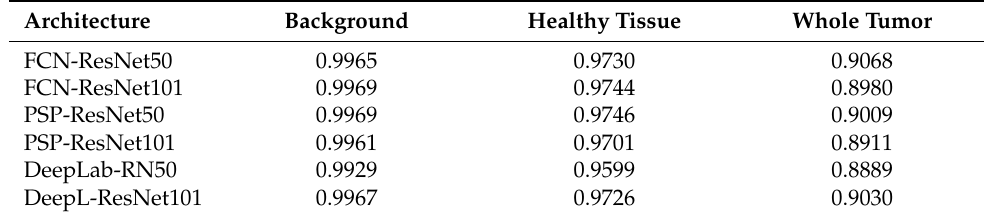
Table 2. Dice for Background (BG), Healthy Tissue (HT), and Whole Tumor (WT).